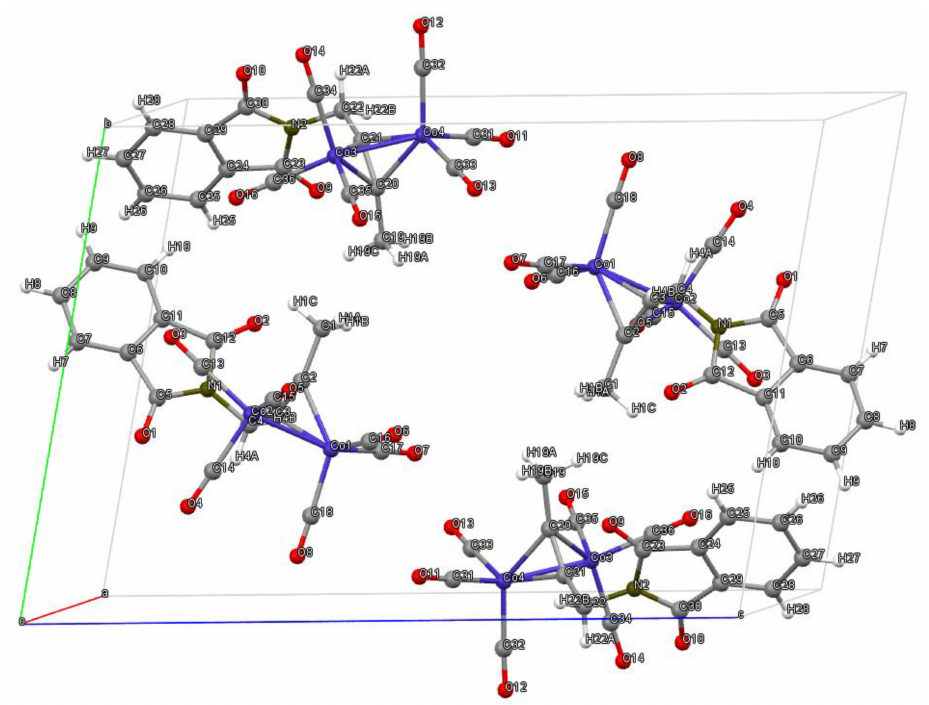
Figure 6. View of the molecular cell of 2 showing the two pairwise arranged independent